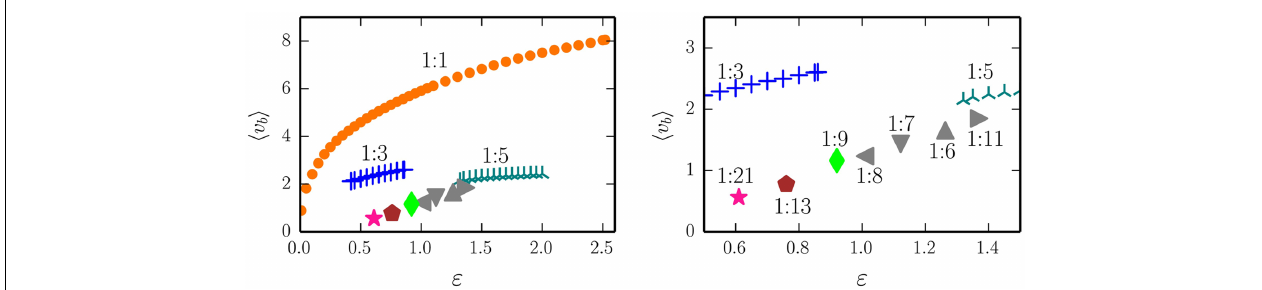
FIGURE 8 | Left: the average speed < v b > of the two-rod barrel for the 1:1/1:3/1:5 (orange dots, blue crosses, dark-cyan stars) modes . The gain is a = 1.9, all other parameters are identical to the ones used for the one-rod barrel. The respective time series and phase-space plots are presented in Figure 9 . The filled symbols denote examples of additional higher order modes, of which the 1:21, 1:13, and 1:9 (pink star, maroon pentagon, and green rhombus) are illustrated in Figure 10 . Right: a blow-up, showing the relative location of the 1:8, 1:7, 1:6, and 1:11 modes found at ε = 1.009, 1.122, 1.263, and 1.370, respectively.